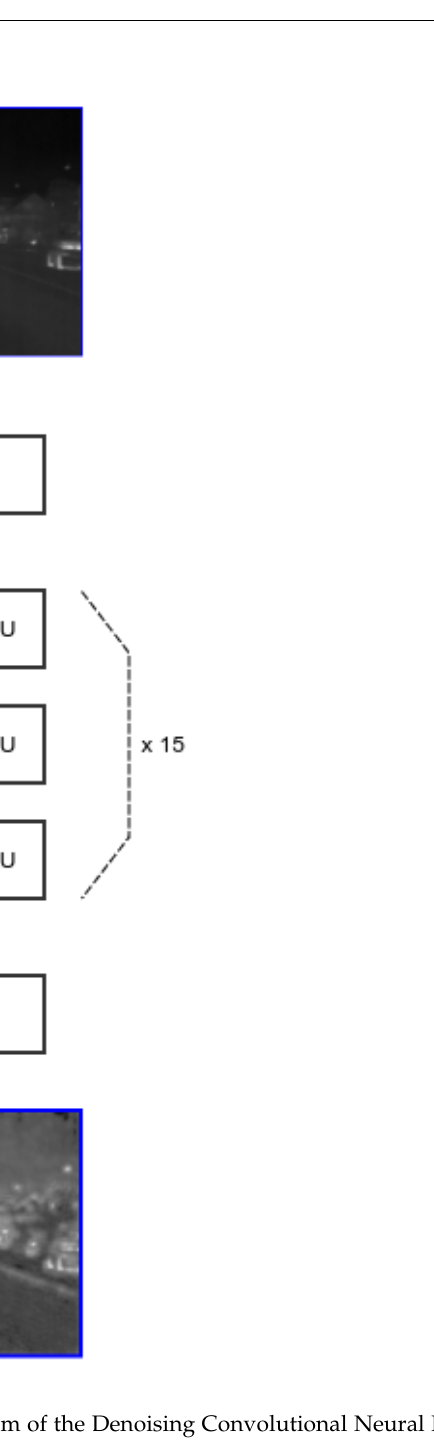
Figure 3. A structure diagram of the Denoising Convolutional Neural Network (DnCNN)-based image